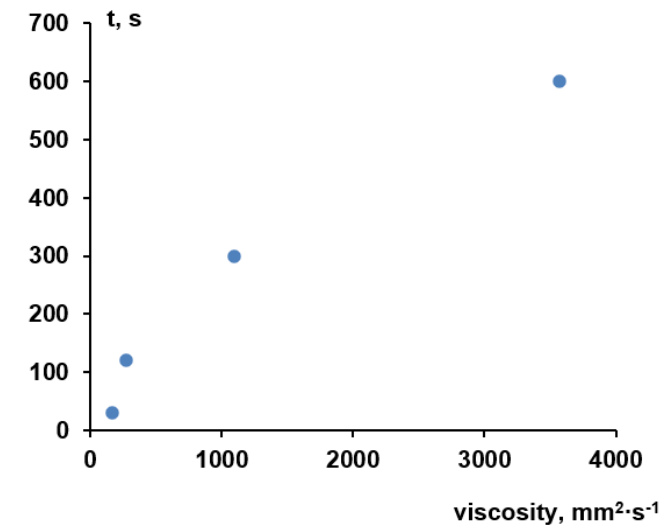
Figure 4. The dependence of membrane formation time on the viscosity of aqueous Praestol 859 solutions used as a coagulation bath (rough plate, T = 25 °C).